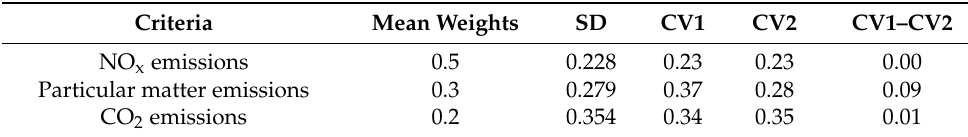
Table 3. Delphi model: consensus on elements, weights, and statistical data.